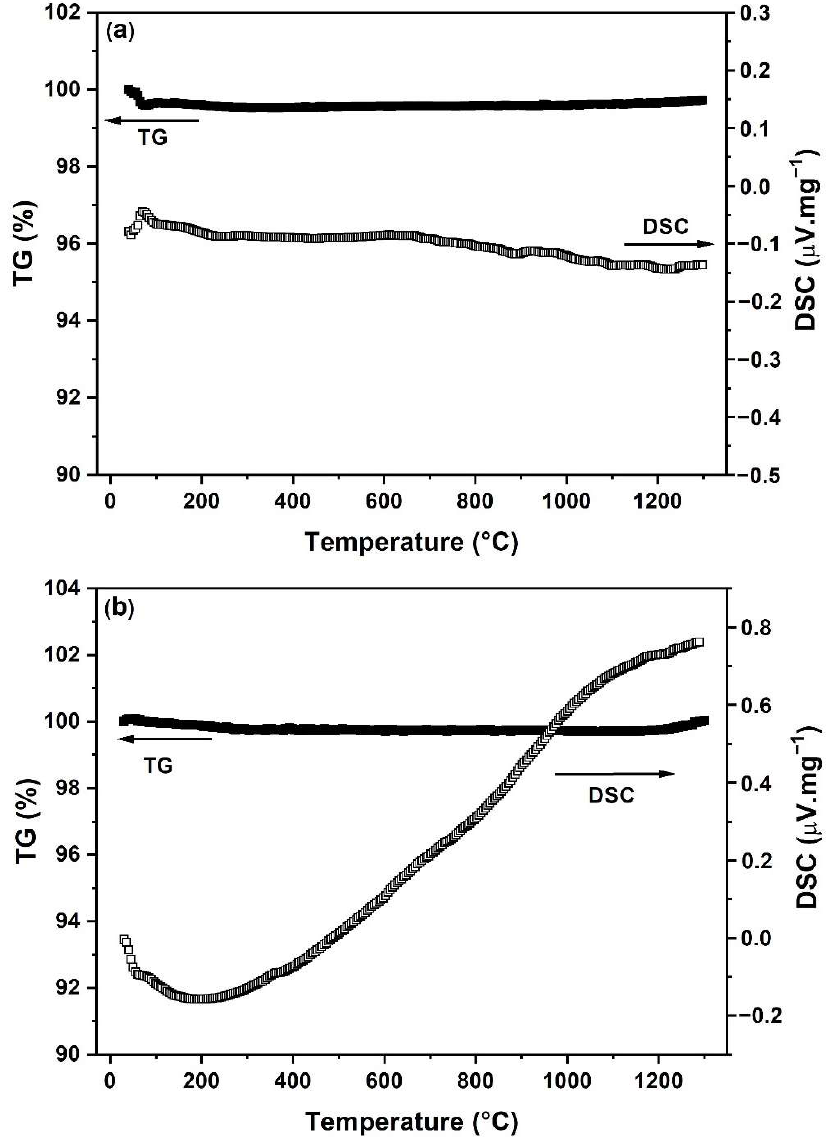
Figure 6. TG and DSC curves of the prepared powders: ( a ) LC-SG, ( b ) LC-SS. SEM analysis was employed to obtain important information about the morphology and size of the produced LC powders. Figures 7 and 8 show the morphology of the LC powders calcined up to 1400 °C under two different magnifications. As shown in the mi- crostructural images (Figure 7a–f), the morphology of the sieved LC-SG powder is block- shaped and the particles are made of agglomerated, small primary particles. The irregular and angular shape of the grains are a result of the crushing process. According to the magnified microstructural images (Figure 7b,d,f), an approximate estimation of the size of the primary nanoparticles in LC-SG powder is less than 200 nm. The size of the nano- crystals became larger as a function of calcination temperature. This agrees with the crys- tallite size estimated from Scherrer’s equation. When the calcination temperature reached 1400 °C, a kind of sintering process took place, and the nanocrystals formed more aggre- gates.